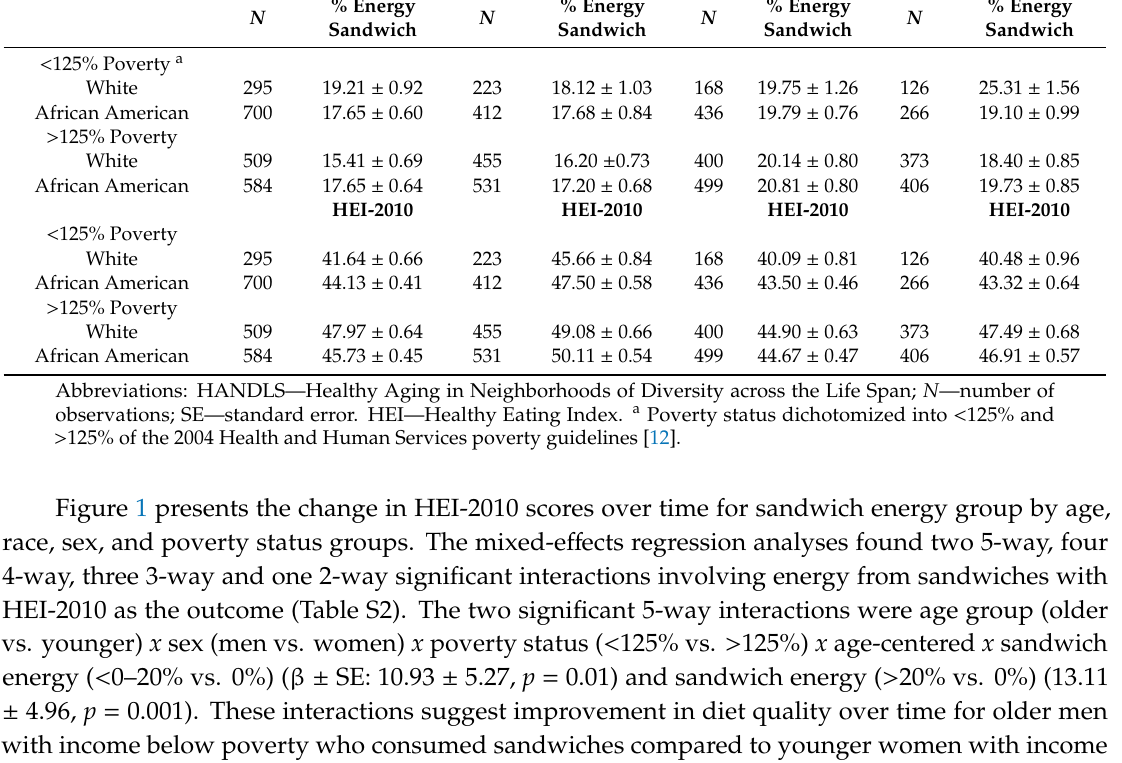
Table 2. Mean ( ± SE) Percentage of Daily Energy Contributed by Sandwiches (%Energy Sandwich) and Health Eating Index (HEI)-2010 Scores by Sex, Age Group, and Poverty Status for HANDLS study participants. Women Men Age at Baseline Visit < 50 Years ≥ 50